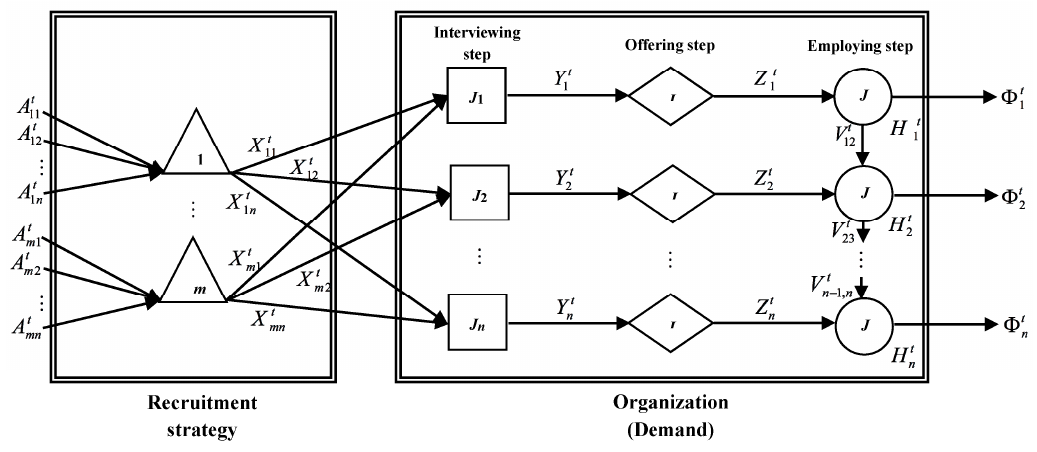
Figure 1. A schematic representation of the problem.